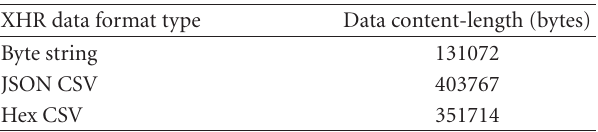
Table 4: Comparison of downloaded content length for three data